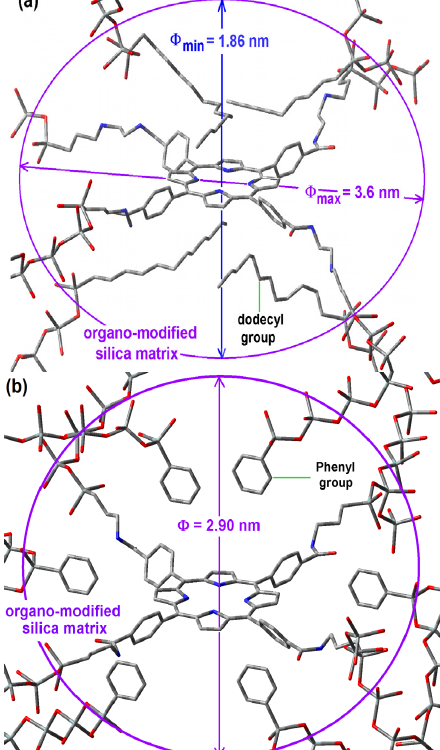
Figure 8. Hypothetical structure of a pore cavity containing the H covalently bonded, through the use of NAEPTES to the pore walls of silica modified with ( a ) dodecyl groups (Do) or ( b ) through the use of APTES and modified with phenyl groups ( Φ